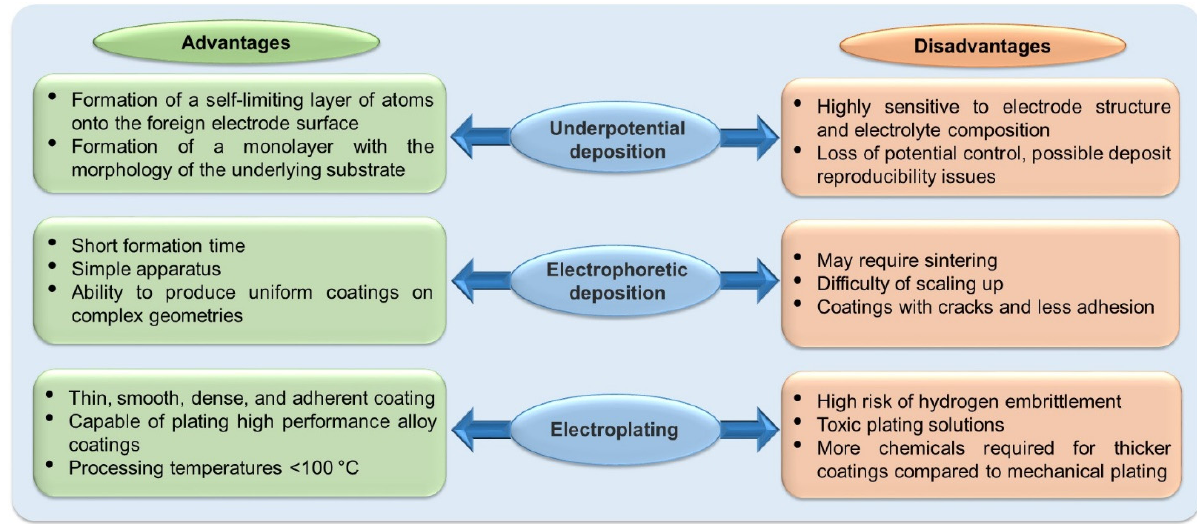
Figure 2. Main advantages and disadvantages of electrodeposition processes.